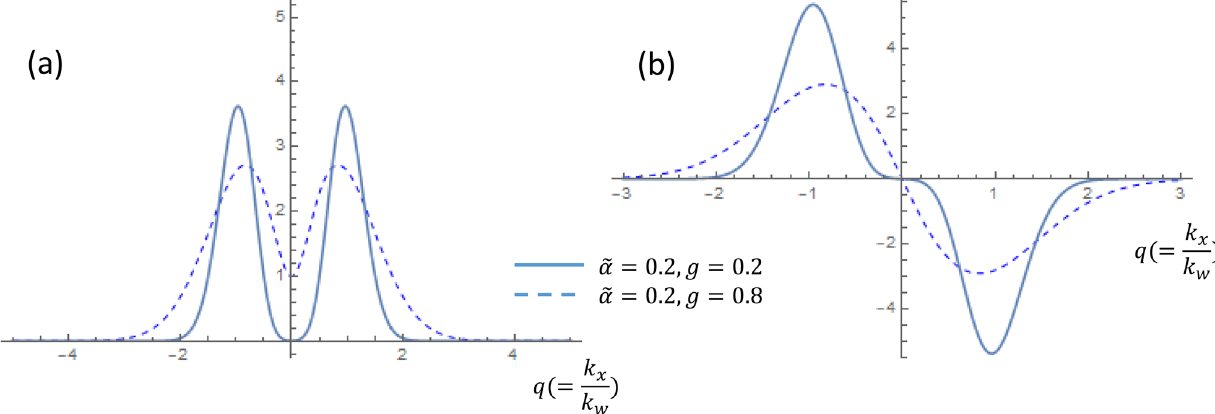
Figure 4. The zero energy eigen-functions in the ( a ) q-even solutions and ( b ) q-odd solutions. The parameters 0.2 and g 0.8 both for 0.2 are chosen for α of g = = ˜ =